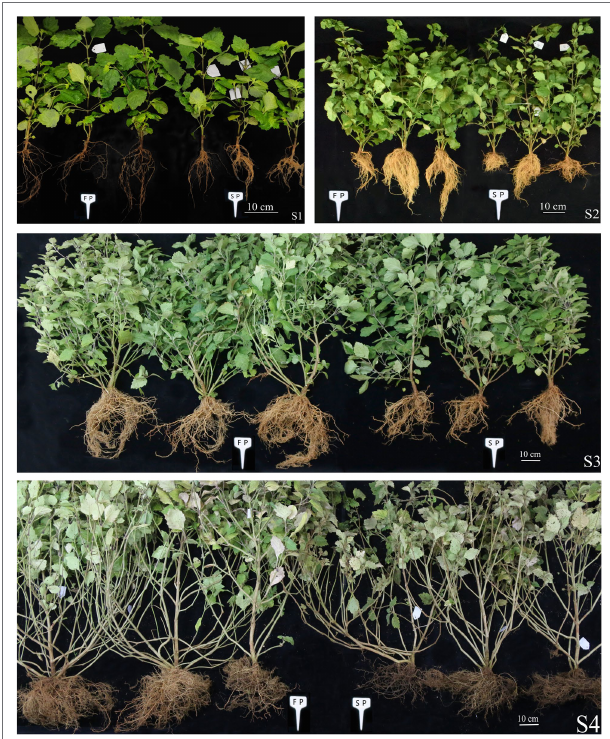
FIGURE 1 | Comparison of the phenotypes of SP and FP patchouli at four growth stage. S1: slow growth period (60 days), S2: fast-growth period (150 days), S3: ripe period (195 days), and S4: fully ripe period (255